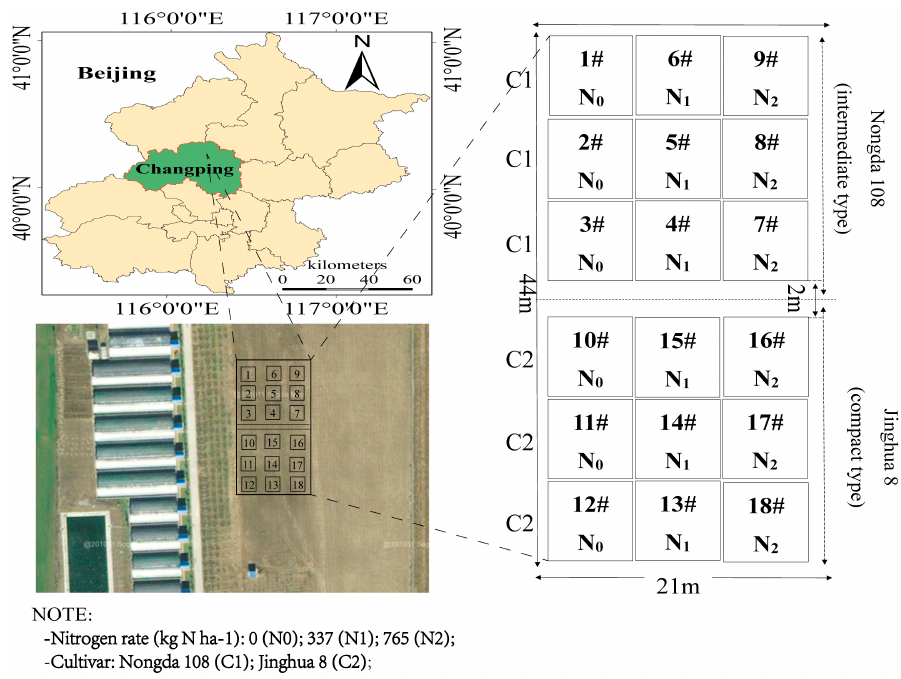
Figure 1. Study plots .